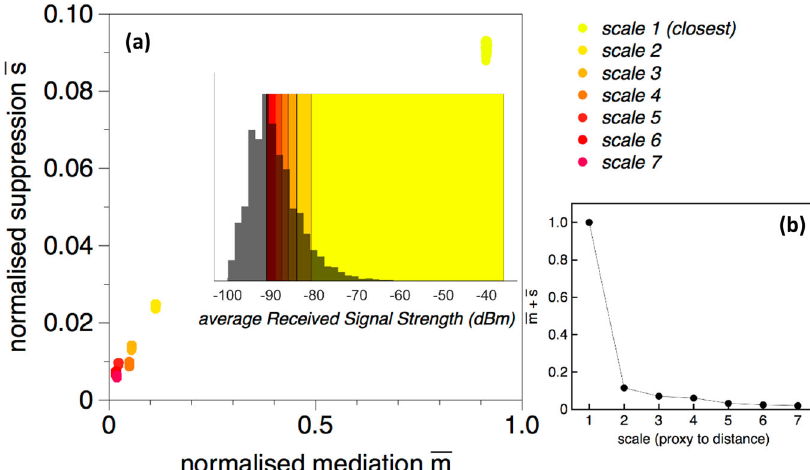
Fig. 7 Modulating mediation. Outer panel a : ð (cid:2) m ; (cid:2) s Þ -plane for the role of the proximity network with respect to the relation of the Facebook and the phone/ SMS network (Copenhagen multiplex), for different proximity networks reconstructed by changing the spatial scale over which links are de fi ned. The network displays a very clear mediating effect only when links represent close physical proximity (yellow), for other spatial scales such effect is lost. Inset panel: Link average weight distribution (received signal strength (RSSI)) is depicted in black. According to this distribution, we build seven non-overlapping RSSI windows. RSSI is inversely related to distance (the larger the signal strength, the closer two nodes are) so these windows represent different spatial scales. b This panel describes (cid:2) m þ (cid:2) s for each spatial scale, further emphasising that only in the closer spatial scale the proximity network is playing a strong mediating